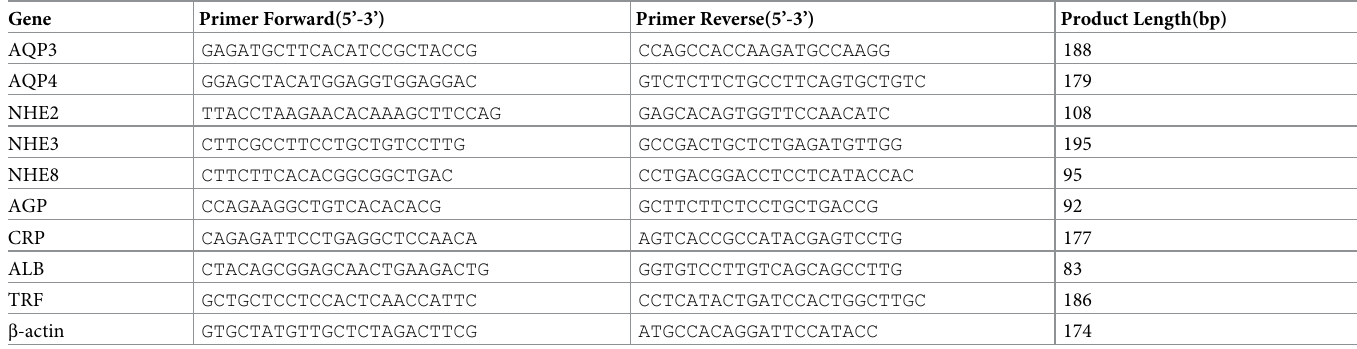
Table 1. The primer